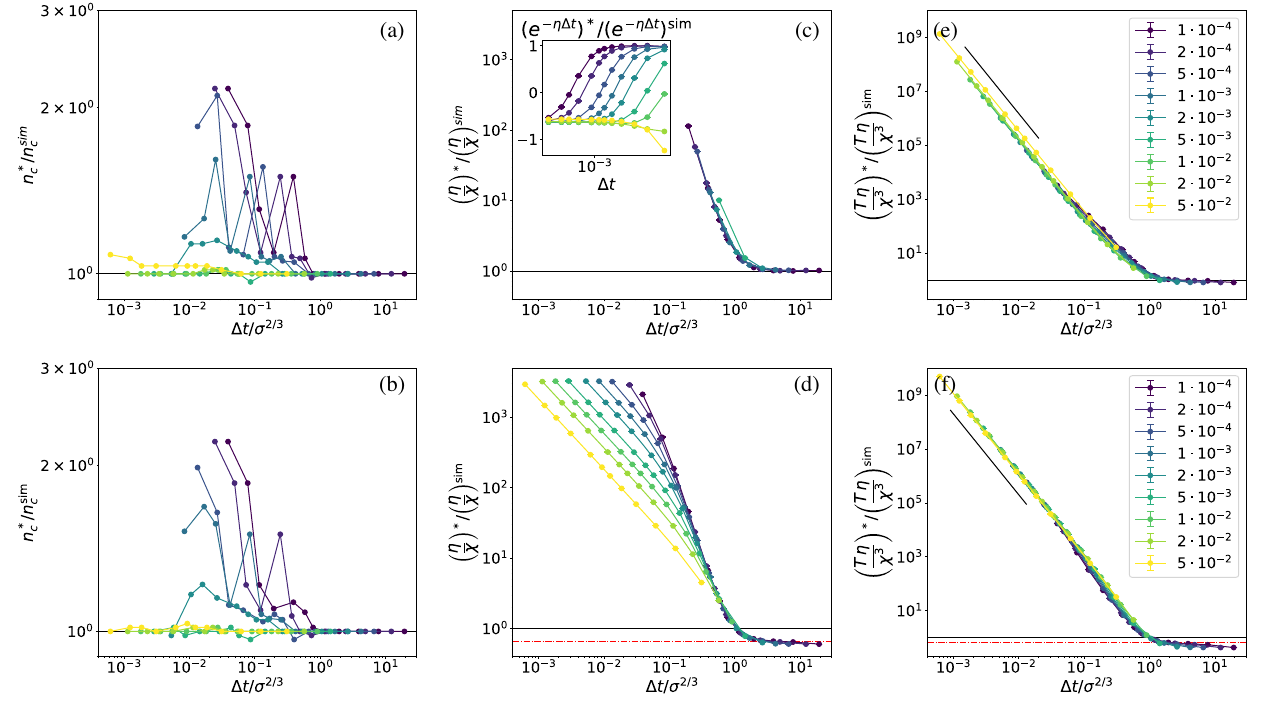
FIG. 6. Effect of measurement error on some selected parameter estimators for the ISM. In the top row, results from the Toeplitz inference scheme are reported; in the bottom row, results from the BBK inference scheme are reported. The rescaling of the inverse sampling rate in the abscissa make the curves in (c) – (f) depart at the same point ( Δ t= σ 2 = 3 ∼ 1 ) from the expected value in the absence of experimental errors (1 for the Toeplitz method; 2 = 3 , marked by the red dot-dashed line, for the BBK method). The collapse of the curves shown in (e) and (f) proves that the control parameter is the ratio between stochastic and experimental noise: T η Δ t 3 = σ 2 . The black lines, having a slope of − 3 , are a guide for the eye. We notice that, for a large noise-to-signal ratio, the estimate of η with the Toeplitz method may be problematic, since estimators of positive definite quantities built with noisy data can become negative, as visible in the inset in (c). We refer to Appendix B 2 for details on the inference formulas. Error bars on (a) and (b) are not shown, for the sake of clarity, whereas in (c) – (f) the 0.95 CI is smaller than the marker